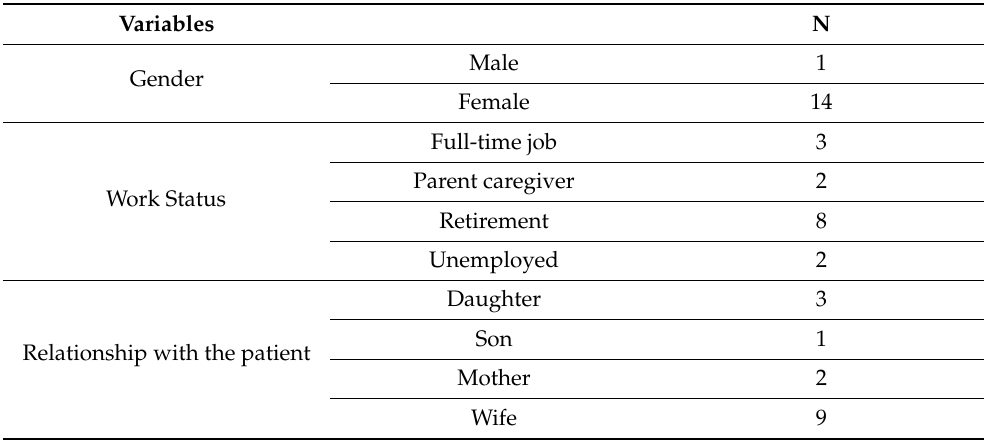
Table 1. Sociodemographic characteristics of the participants.